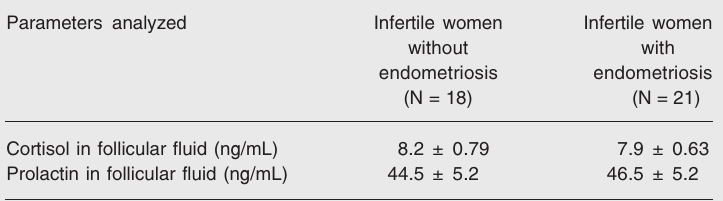
Table 4. Cortisol and prolactin concentrations in follicular fluid of infertile women without endometriosis and infertile women with endometriosis. Parameters analyzed